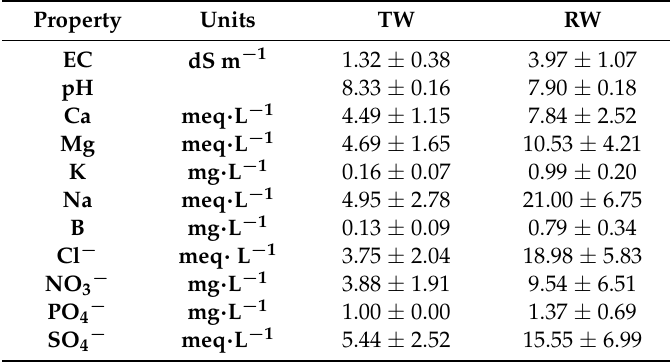
Table 1. Physical and chemical properties for Tajo-Segura transfer water and reclaimed water in 2017. Property